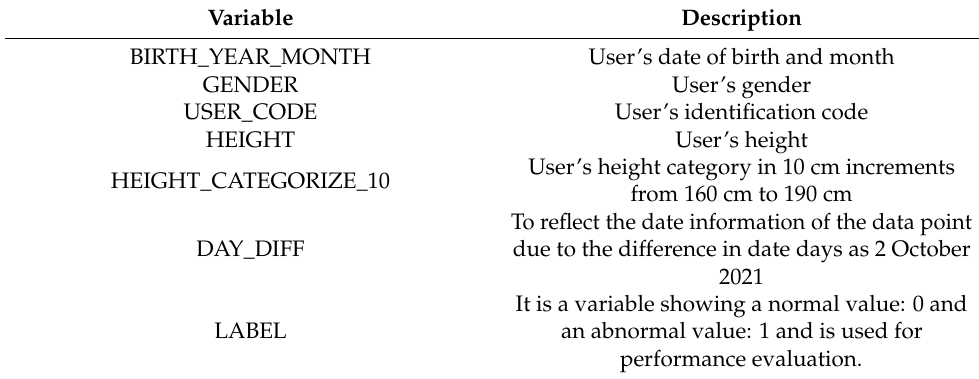
Table 3. Variables, derived variable, and variable descriptions of user information dataset.